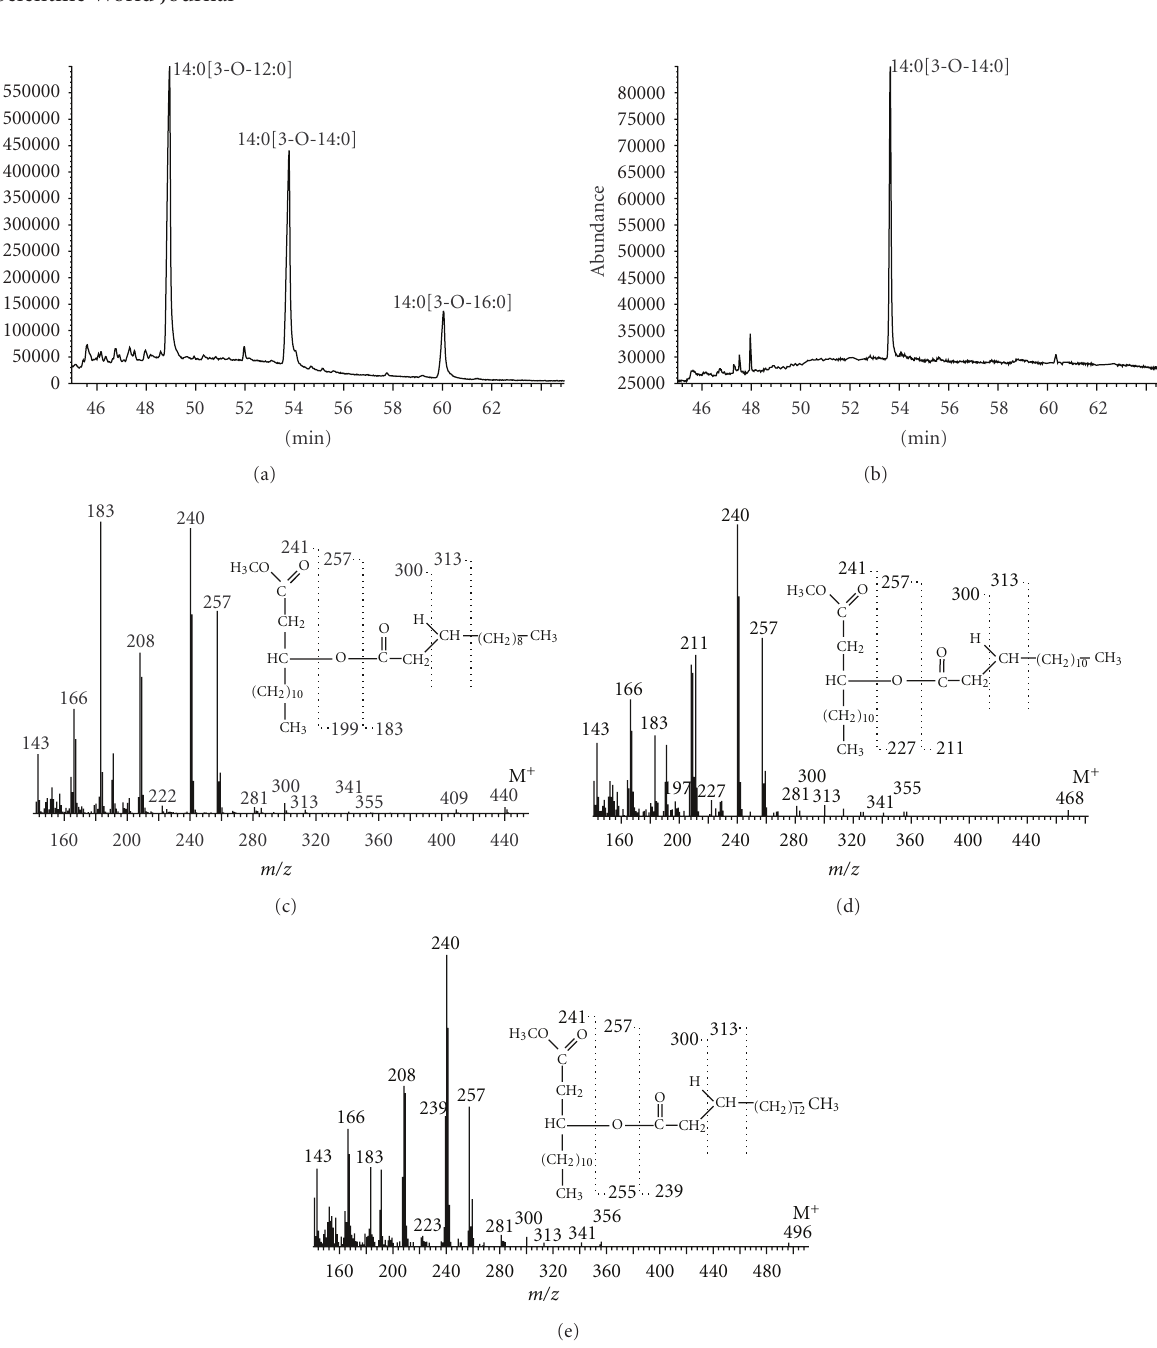
phosphate groups. Rietschel et al. [53] claim that the fewer phosphate groups occur in lipid A the less it is active. The lack of one of the phosphate substituents results in 100 times lower biological activity of LPS. Lipid A of D. desulfuricans is phosphorylated the thing that influences its